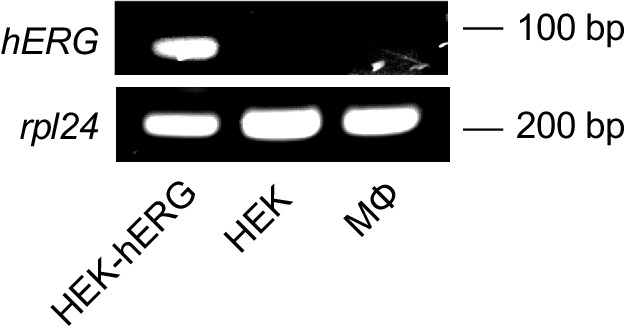
The hERG gene is not expressed in human monocyte-derived macrophages.RT-qPCR was performed in order to detect hERG mRNA expression in macrophages, in hERG-transfected and non-transfected HEK293 cells (kind gift from Craig T. January, University of Wisconsin–Madison). rpl24 was used as control gene.